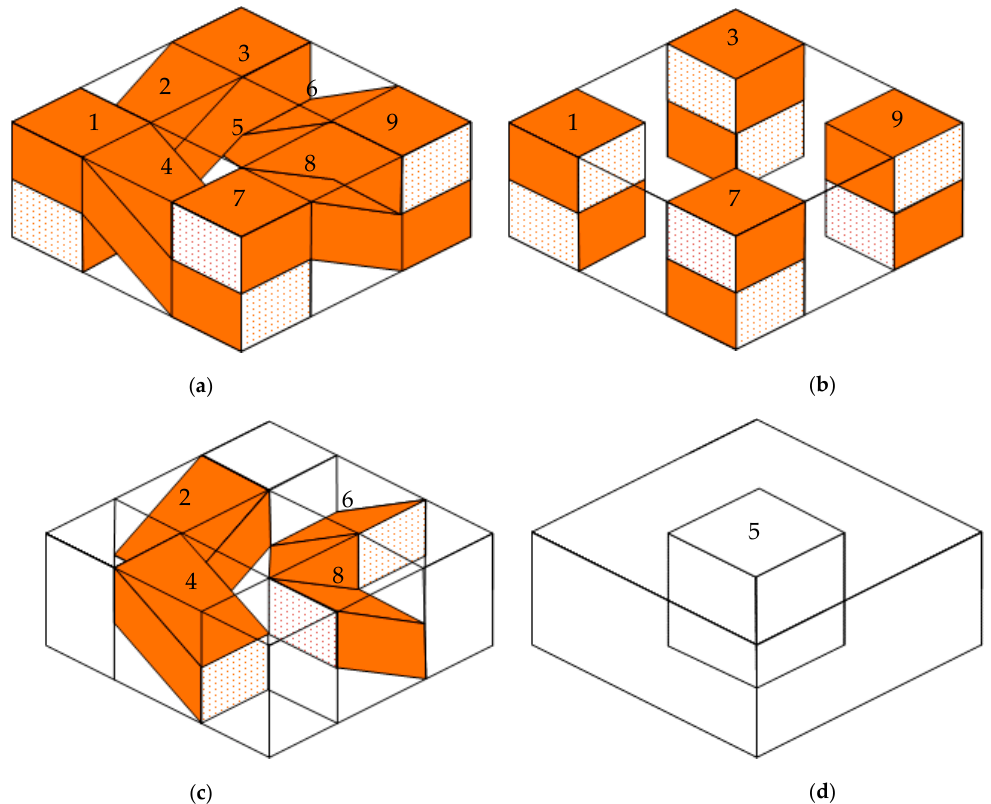
Figure 2. Superposition method for plain weave composite. ( a ) Partition of unit cell; ( b ) Tow part; ( c ) Undulated tow and resin part; ( d ) Resin part.